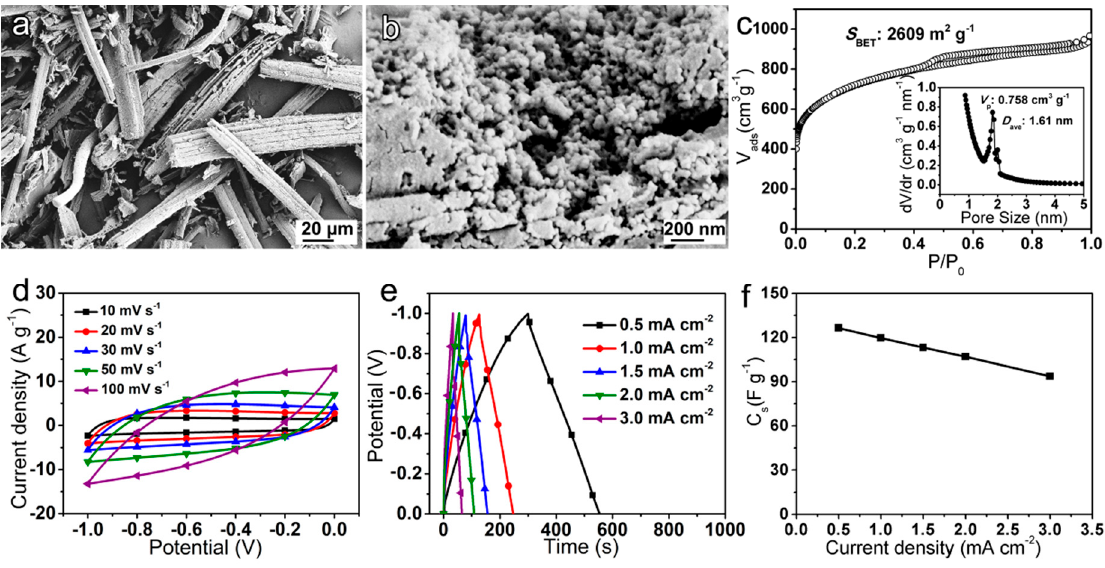
Figure 6. ( a , b ) SEM images, ( c ) N 2 (77 K) adsorption/desorption isotherms and BJH pore size distribution curves (the inset), ( d ) CV curves, ( e ) CD curves, and ( f ) C s of the as-prepared activated carbon (AC) material.